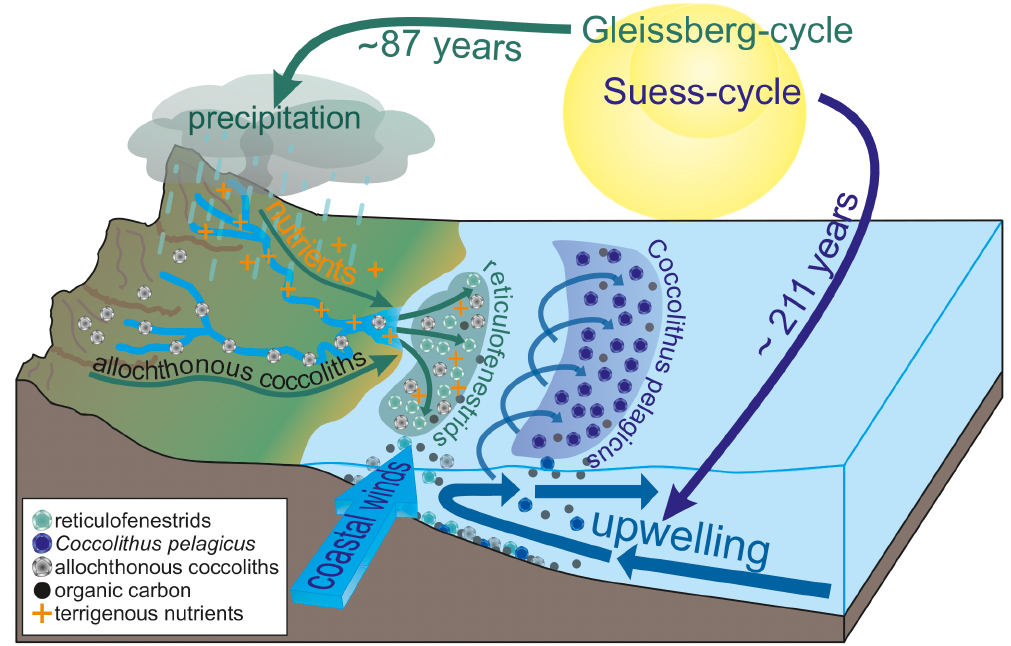
Figure 9. Model depicting the Suess and Gleissberg cycles and the dominant influence they had on different paleoenvironmental systems. The (combined upper ∼ 113years and lower ∼ 65years) Gleissberg cycle exerts control on precipitation, which in turn controls freshwater and terrigenous material input as well as nutrient influx from the hinterland, and variations in the abundance of reticulofenestrids. The Suess cycle ( ∼ 211years) in turn exerts control over local coastal upwelling, as well as the amount of Coccolithus pelagicus . Both cycles are reflected in primary productivity proxies, caused by the export of organic matter from both systems to the ocean